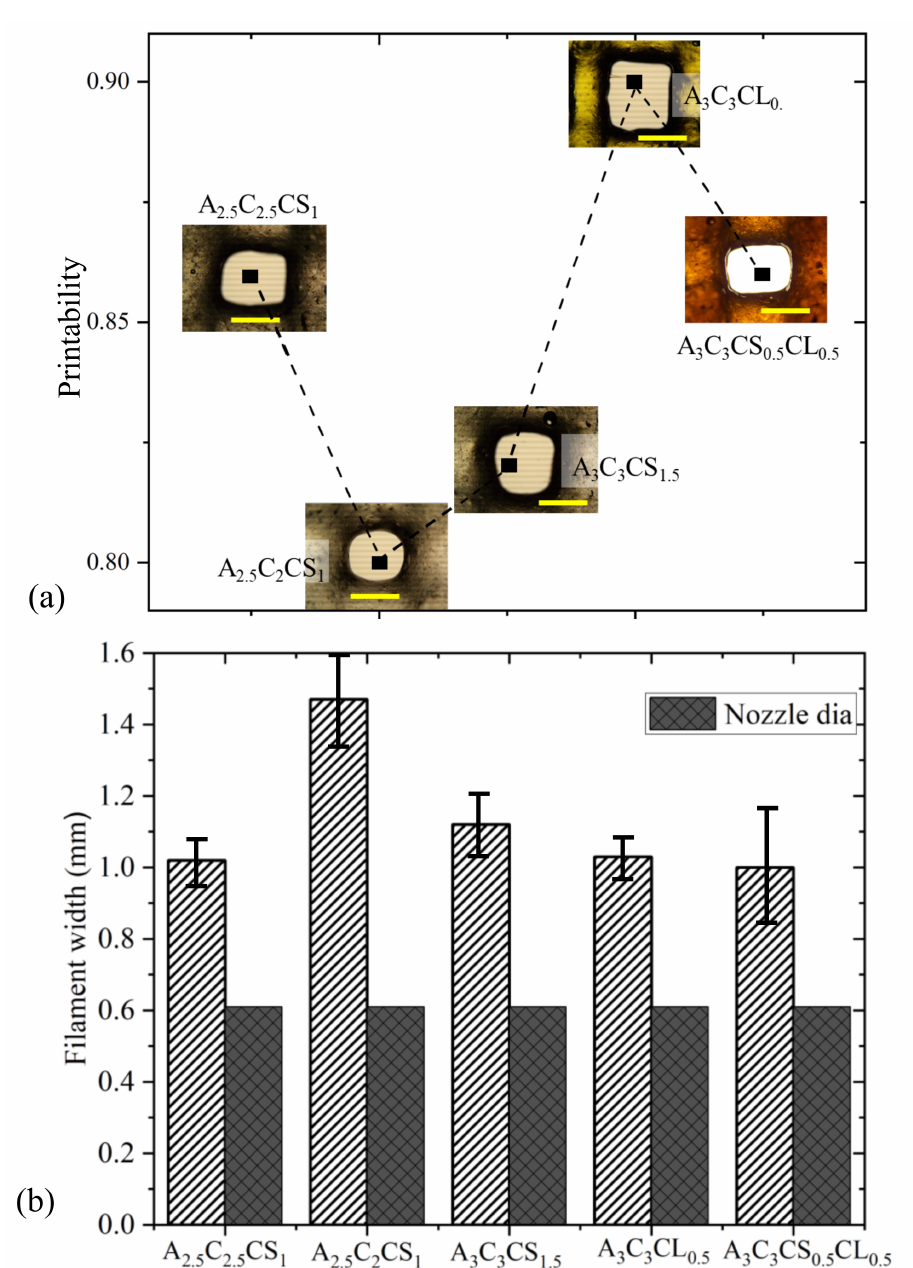
Figure 10. ( a ) Printability of all compositions for a pore size of 2.5 mm × 2.5 mm, and ( b )